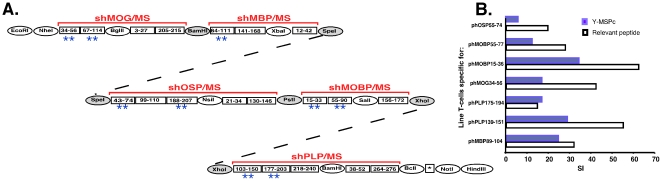
Generation of Y-MSPc and its immunofunctional properties.(A) Scheme for the construction of the Y-MSPc-encoding gene. **, denotes epitope clusters containing human sequences that are encephalitogenic for C57Bl/6J (H-2b) [36], [39], [55], [56] or SJL/J (H-2s) [57], [58], [59], [60], [61], [62] mice and also for BSF1 (H-2b/s) mice (Table S1). DNA and derived amino acid sequences of Y-MSPc are shown in Fig. S1. (B) Y-MSPc is adequately processed and presented to relevant epitope-specific encephalitogenic T-cell lines. Epitope-specific line T cells (1.5×104/well) raised from peptide-primed LN cells isolated from BSF1 mice were tested for their proliferative response to their priming peptide (5 µg/ml ) or Y-MSPc (5 µg/ml ), in the presence of syngeneic irradiated APCs (5×105/well). Each bar on the histograms represents the mean stimulation index (SI) of triplicate cultures (SD<10%). Background cpm ± SD for phMBP89-104-, phPLP139-151-, phPLP175-194, phMOG34-56, phMOBP15-36-, phMOBP55-77-, and phOSP55-74-specific line T-cells were 249±15, 374±21, 1555±216, 1767±436, 2937±121, 261±69, and 3217±426, respectively.